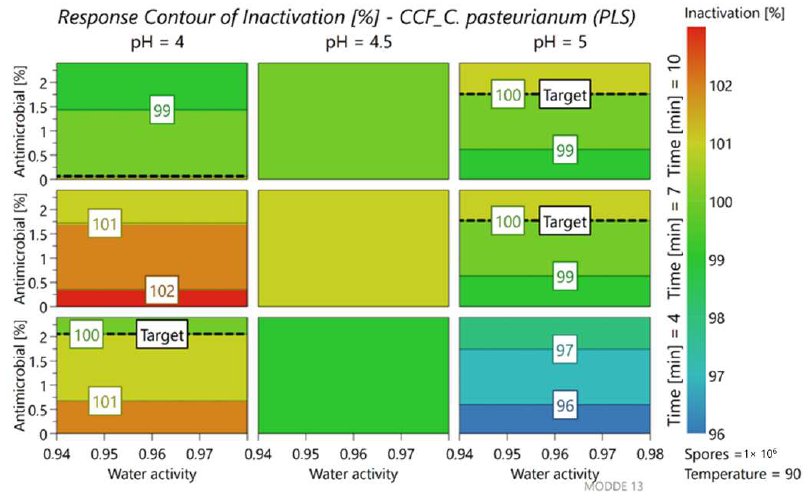
Figure 7. Contour plot representing the percent of spore inactivation of C. pasteurianum LMG 3285, at different levels of parameters.